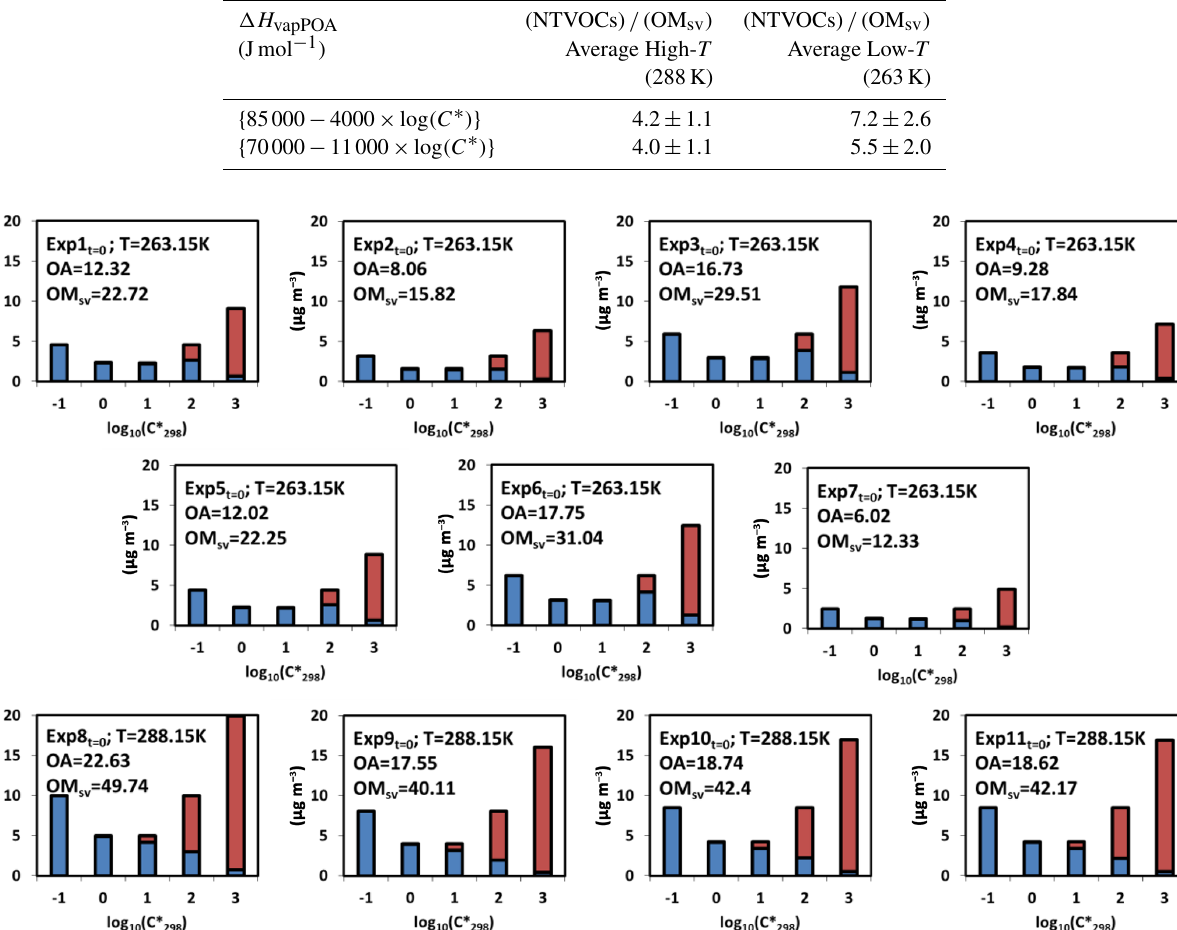
Table 3. Solutions used for primary organic aerosol enthalpies of vaporization with averages and standard deviations of the (NTVOCs) / (OM sv ) ratio.